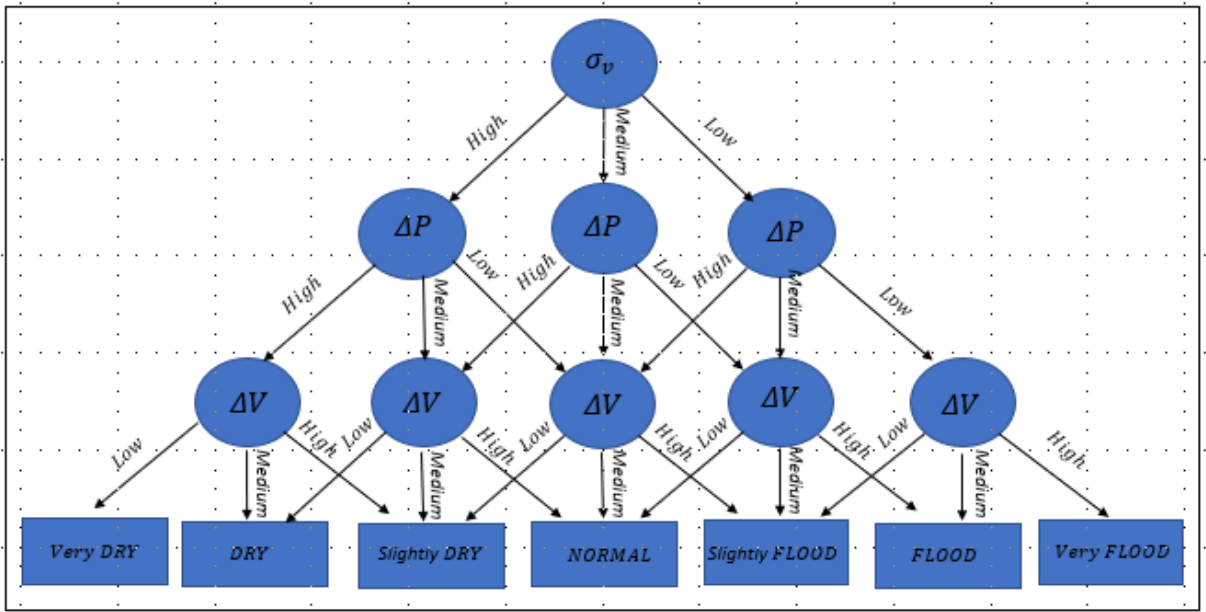
Figure 4. Fuzzy decision tree to estimate the operational status of the PEMFC.